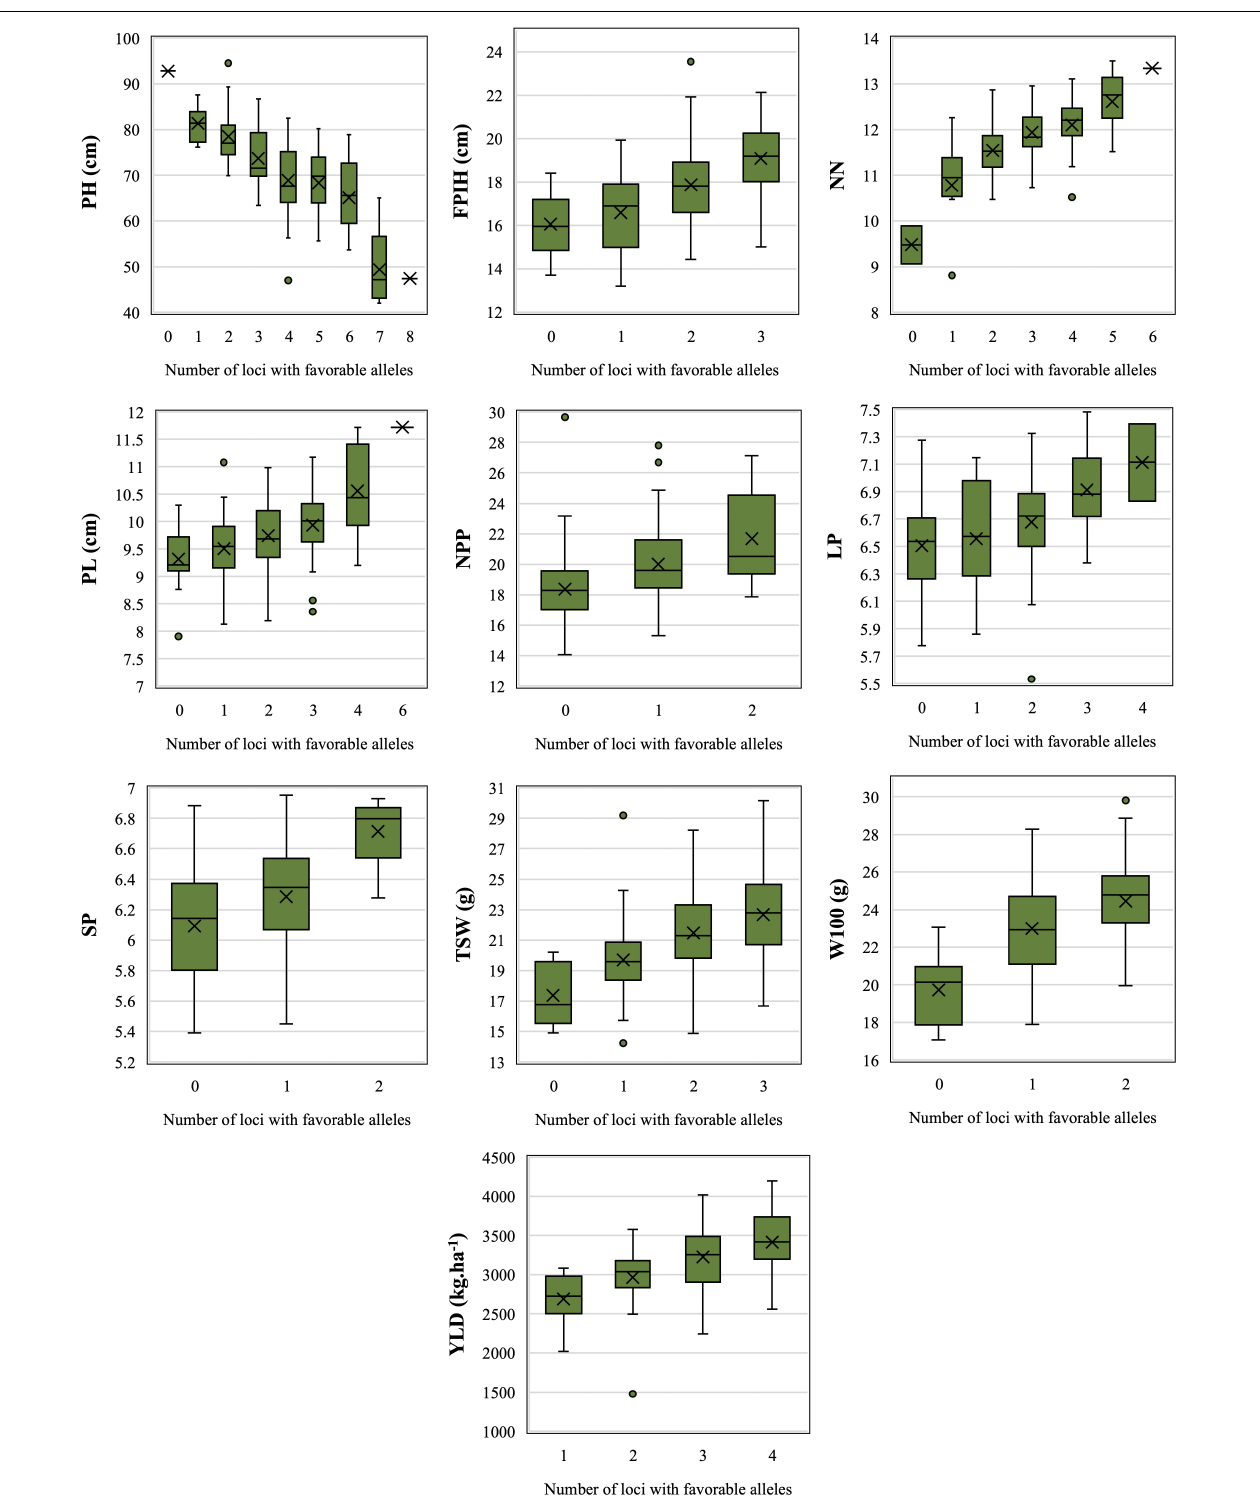
FIGURE 3 | Accumulation of loci with favorable alleles in relation to adjusted means (LSmeans) for morpho-agronomic traits of common beans detected in accessions belonging to the Brazilian Diversity Panel (BDP). PH, plant height (cm); FPIH, first pod insertion height (cm); NN, number of nodules; PL, pod length (cm); NPP, total number of pods per plant; LP, number of locules per pod; SP, number of seeds per pod; TSW, total seed weight per plant (gm); W100, 100-seed weight (gm); YLD, grain yield (kg.ha − 1 ).